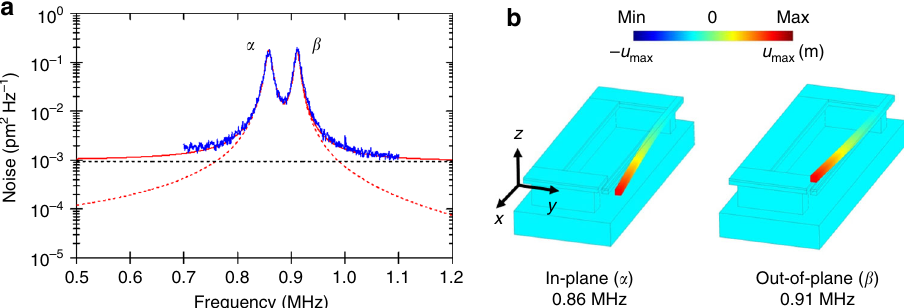
Fig. 2 Characterization of the nanomechanical modes. a Blue curve: radio frequency spectra of the room temperature cantilever Brownian motion, displaying two fundamental mechanical resonances, labelled α and β . The red curve is a fi t resulting from the sum of the spectral noise for two harmonic oscillators (red dashed curve) added to the noise fl oor of the balanced photo-diode unit (black dashed curve). b Numerical modelling of the amplitude of deformation u max for each mechanical mode. The α resonance corresponds to the cantilever oscillations in the Oxy plane of the SRR and the β resonance corresponds to oscillations in the